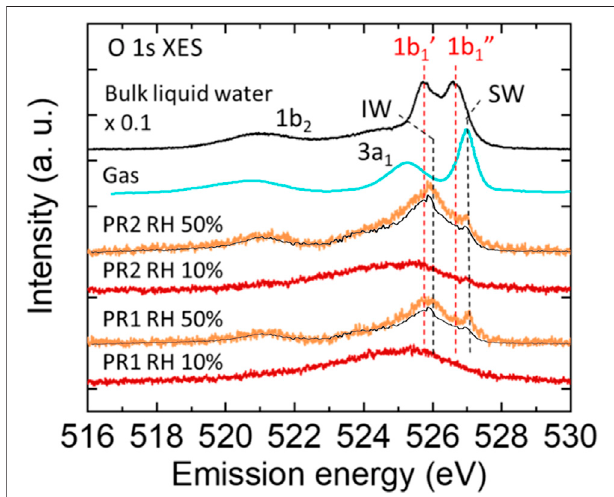
FIGURE 2 | O 1s XES spectra of water in the polyrotaxane polymer fi lm at RH 50% (orange) obtained by subtracting the corresponding polyrotaxane spectra at a dry ( < RH 10%) condition (red). The intensity of the bulk liquid waterspectrum(black) ismultiplied by0.1. The gas phase spectra (blue) is obtained from other report (Weinhardt et al., 2012). The background XES contribution from water adsorbed on the Au surface is also plotted (black line) on each RH 50%